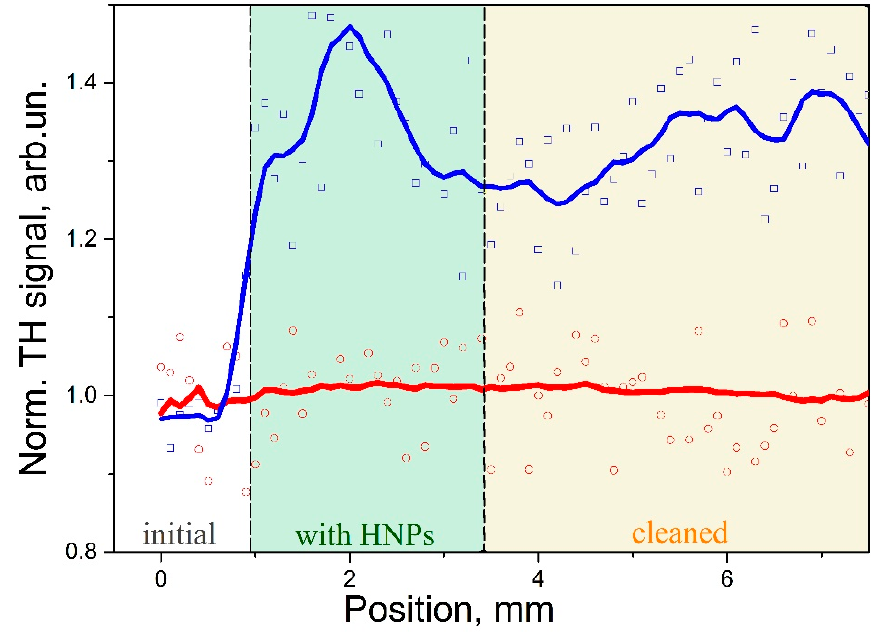
Figure 6. The THG signal scanning in plane of the sample under picosecond range pulsed laser excitation at 1064 nm for glass cover slip (blue) and cover glass coated by P(VDF-TrFE) (red). Filled areas correspond to the initial area, area with deposited ZnO HNPs and cleaned part in ultrasonic bath. Signals for coated and uncoated areas are normalized on the response at initial area. Solid lines obtained by moving average filtering of raw data, for better visualization of signal variation.